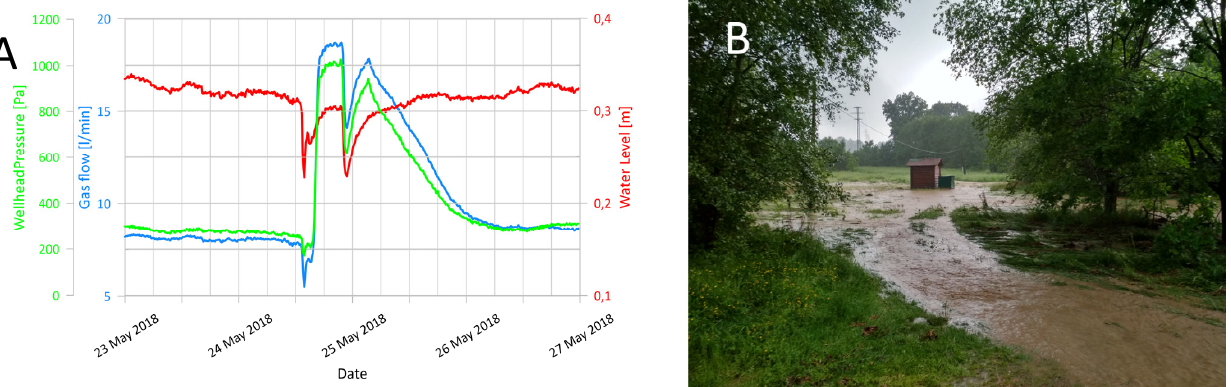
Figure 7. ( A ) Response of the gas flow (blue), wellhead pressure (green), and water level (red) of F1 well to a local flood documented in ( B ). Photo taken by Josef Vl č ek on 24 May 2018 at 15:42 local time. View from F1 looking westwards. The wooden hut sits on top of well F2.